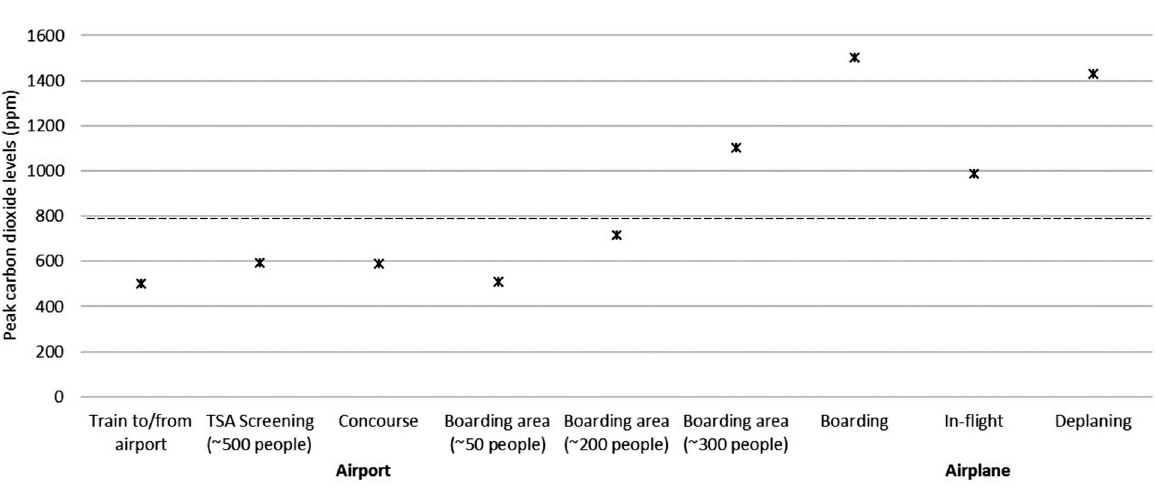
Figure 1: Air Travel . Peak carbon dioxide levels in different areas during travel on a train to and from the airport and inside the airport and airplane. Peak levels above 800 PPM (dotted line) were considered an indicator of suboptimal ventilation for the number of occupants present. PPM, parts per million. TSA, Transportation Security Administration.